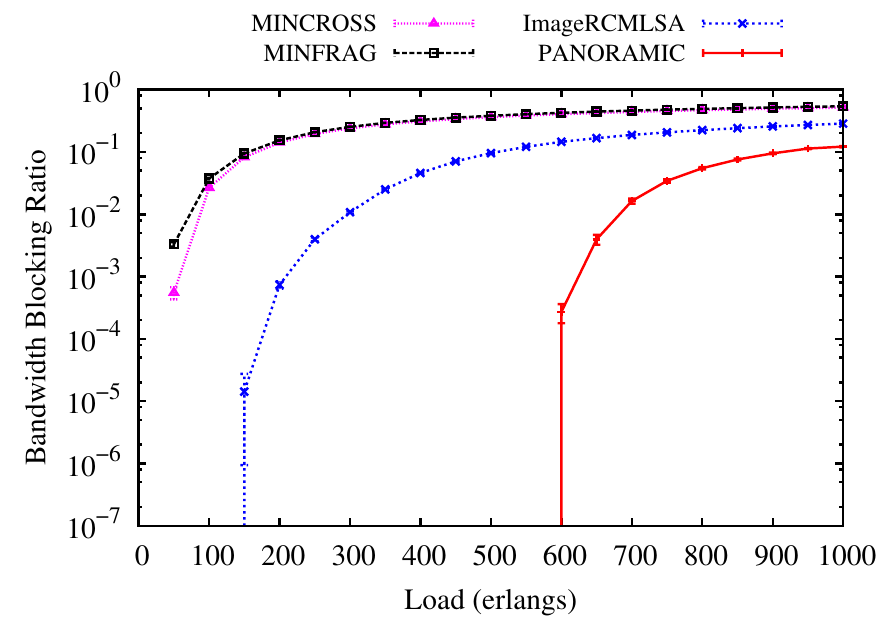
Figure 5. Bandwidth Blocking for USA